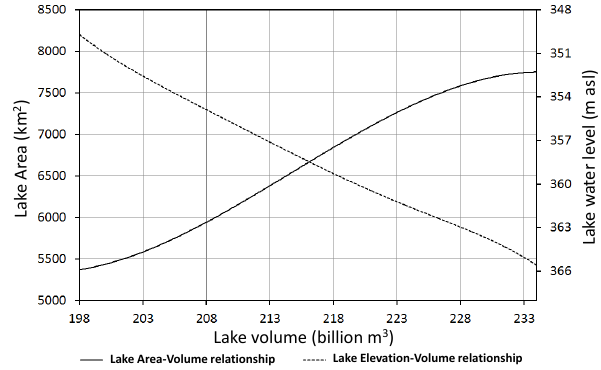
Fig. 3. Relationship between Lake Turkana depth, surface area, and volume derived from seamless lake elevation bathymetry dataset and GIS